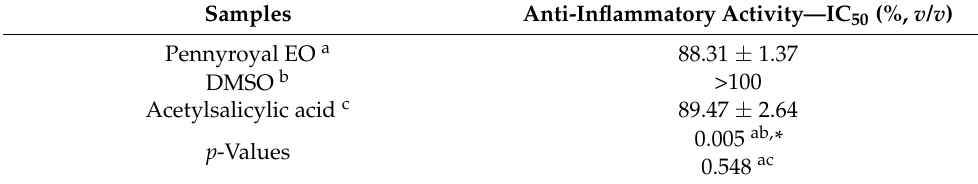
Table 6. Anti-inflammatory activity of pennyroyal